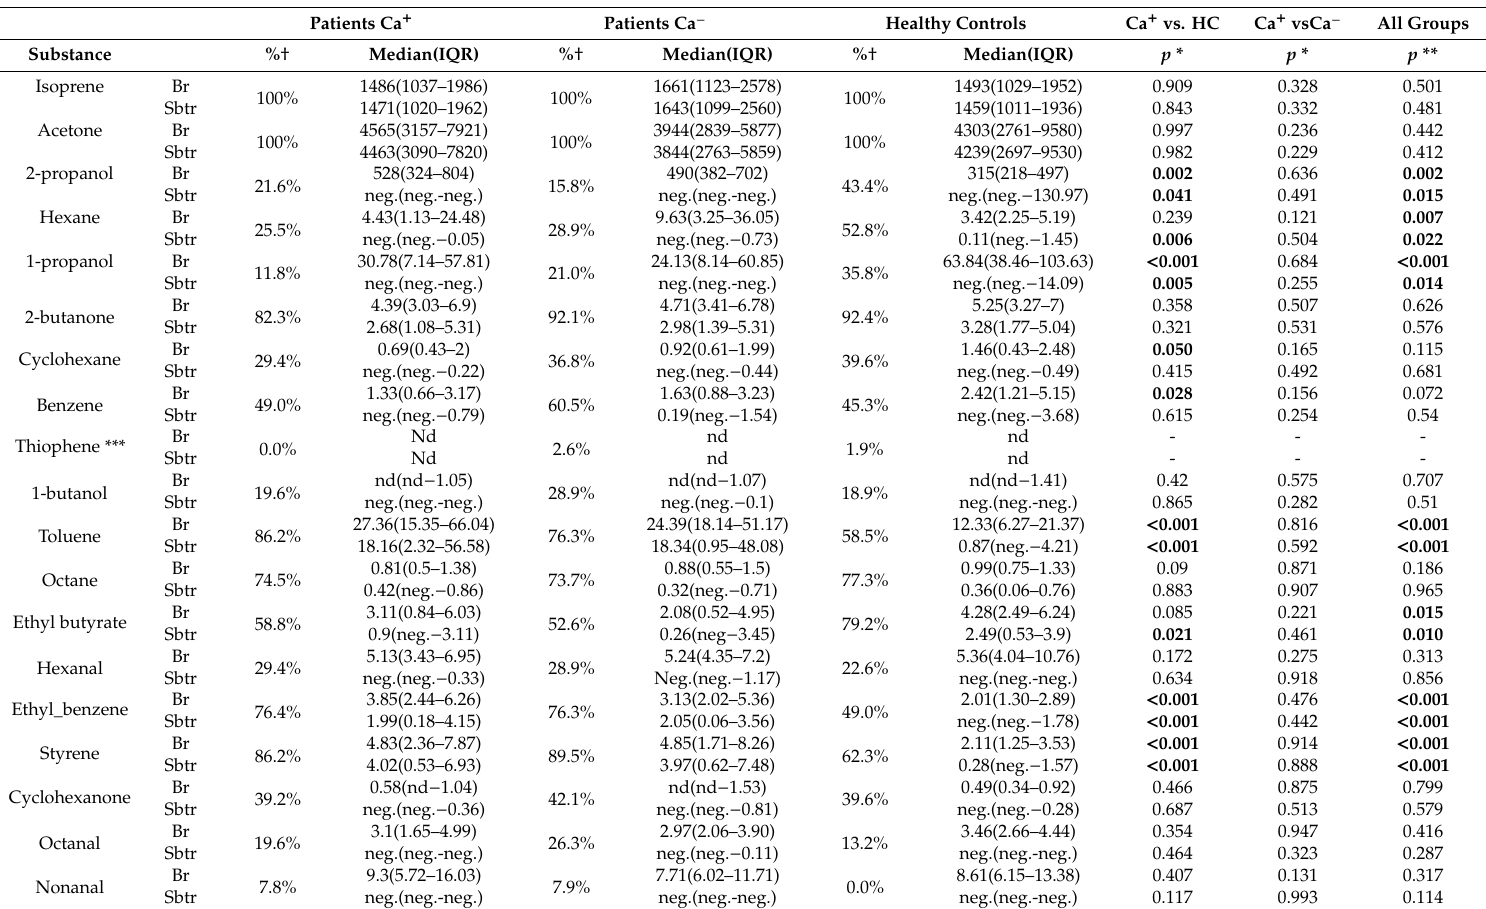
Table 3. Concentrations of VOCs biomarkers (ng / L) in breath before and after ambient air correction and significance of their di ff erences between investigated